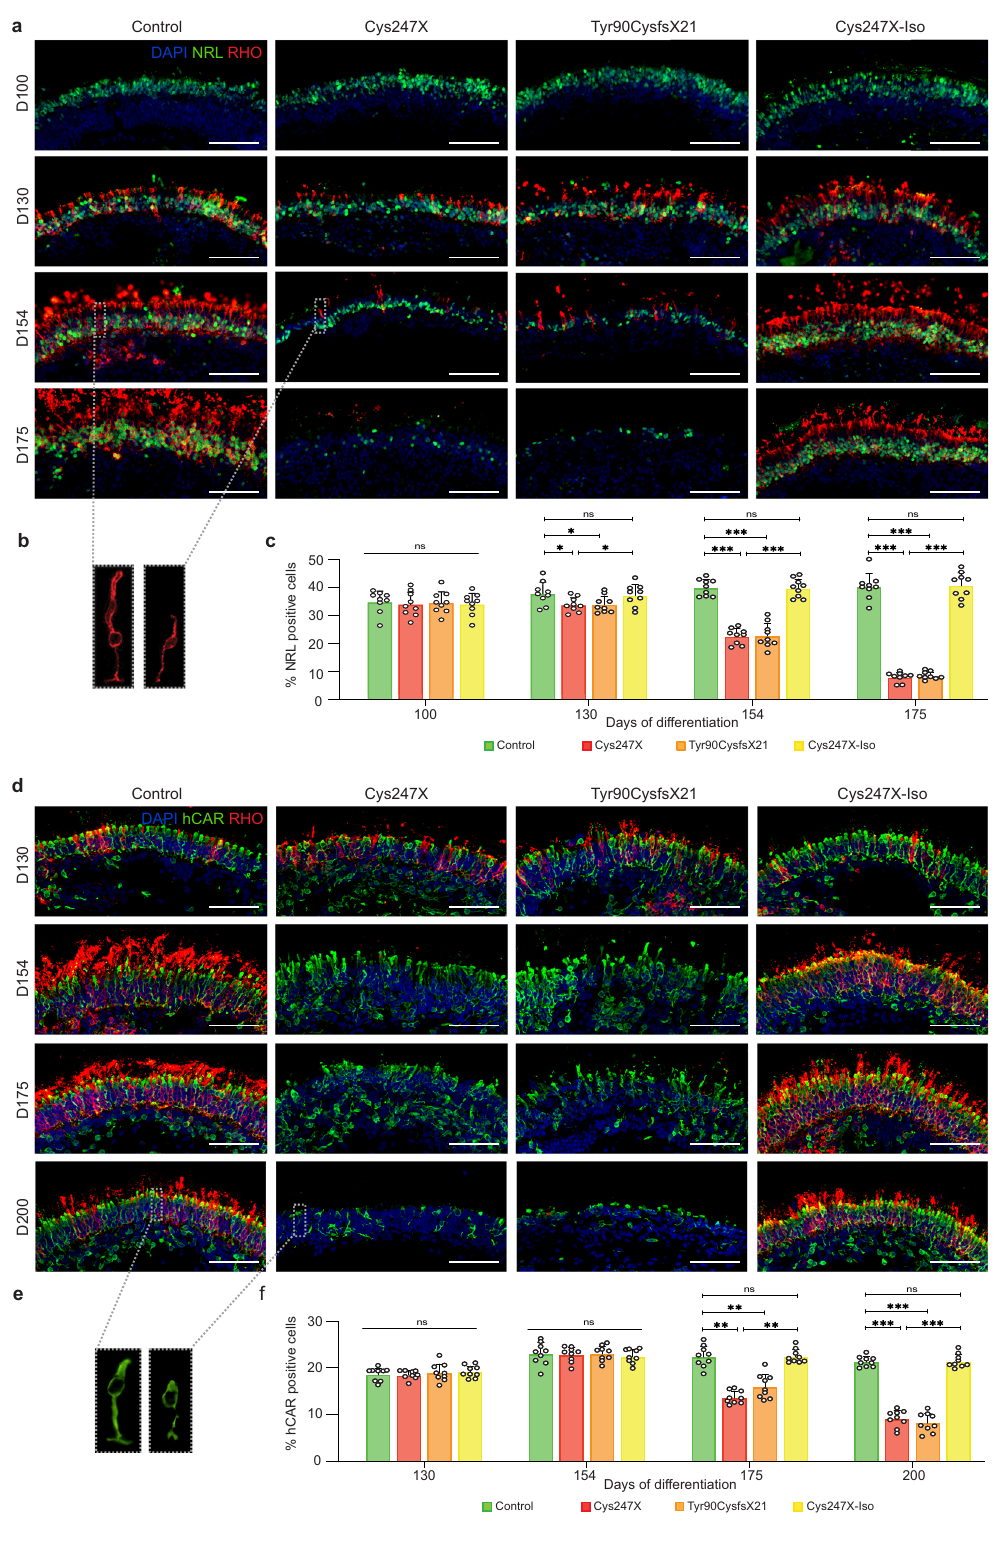
mutations did not affect rod and cone photoreceptor differentia- tion. However, a striking decrease of NRL staining occurred after D130 in Cys247X and Tyr90CysfsX21 organoids (Fig. 4a), with a decrease in the number of NRL-positive rods reaching <10% in these structures at D175 (Fig. 4c). A similar degenerative pro fi le